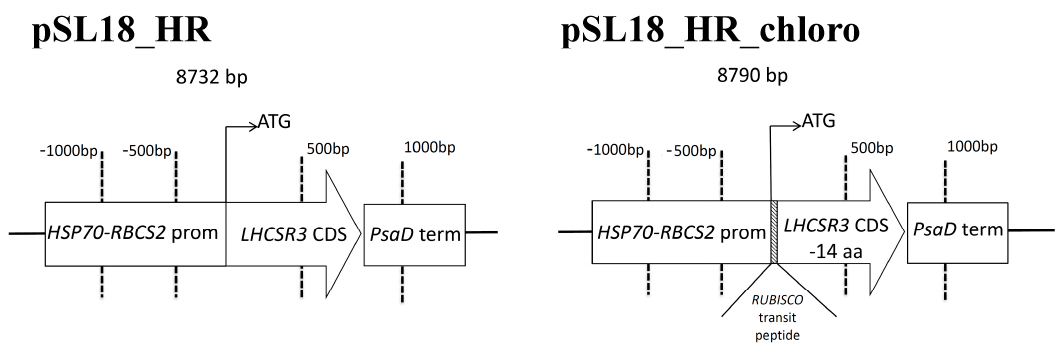
Figure 1. Schematic maps of the vectors used for npq4 lhcsr1 transformation. LHCSR3 coding sequence ( LHCSR3 CDS) was cloned in pSL18 vector under the control of promoter obtained by fusion of HSP70 and RBCS2 promoter (pSL18_HR). In the case of pSL18_hR_chloro, LHCSR3 coding sequence was truncated at the 5 ′ in order to remove the codons coding for the first 14 aminoacids of the protein: chloroplast transit peptide was thus substituted with RUBISCO (rbcs) small subunit transit peptide. For both vectors PsaD terminator sequence was used as terminator.